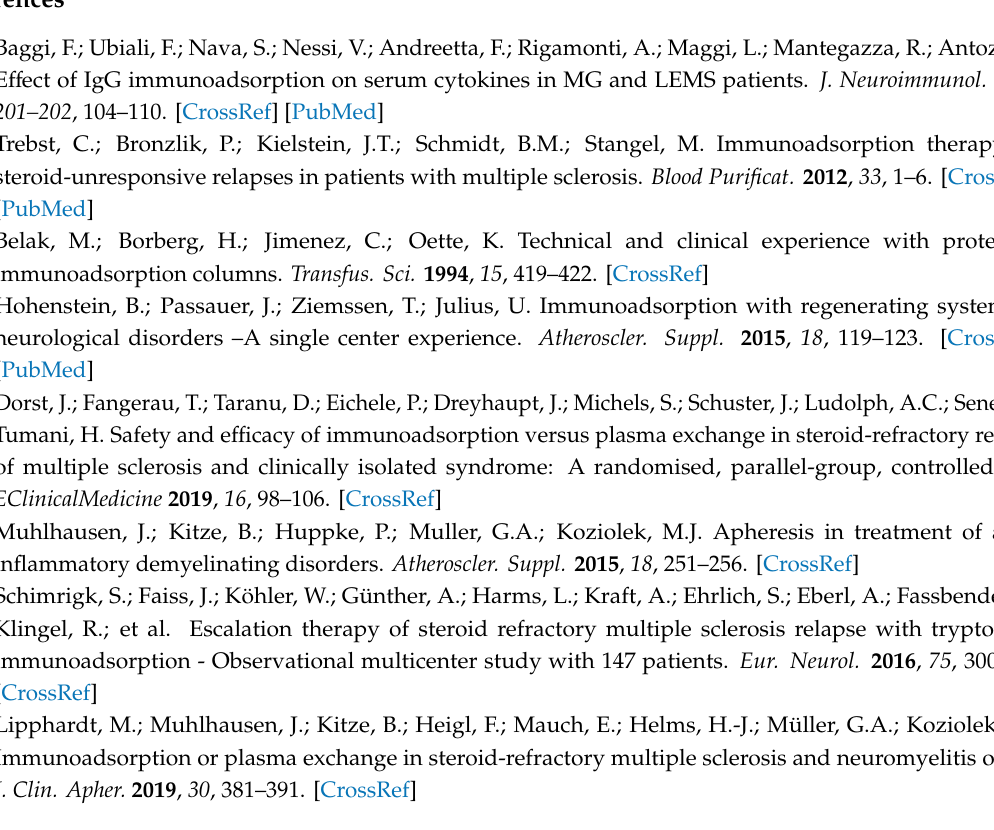
Supplementary Table S1: Baseline Characteristics of patients with MS / CIS; Supplementary Table S2: Baseline Characteristics of patients with CIDP; Supplementary Table S3: Baseline Characteristics of patients with